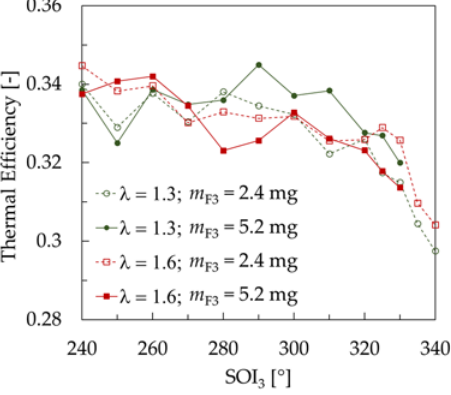
Figure 9. Net indicated thermal efficiency versus SOI 3 timing for all investigated conditions.